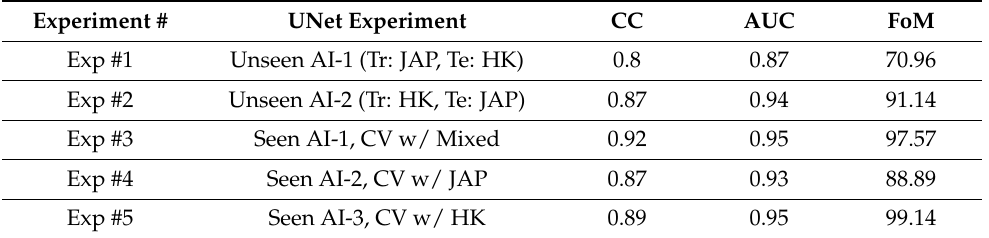
Table 3. Performance and statistical parameters of the test dataset of all experiments.